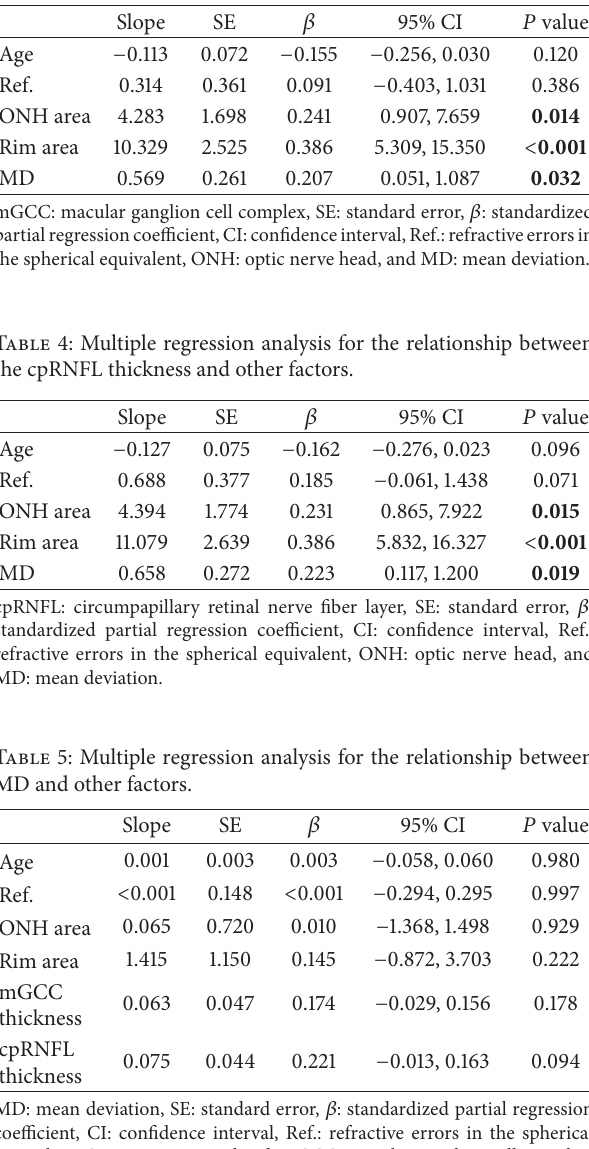
Table 3: Multiple regression analysis for the relationship between the mGCC thickness and other factors.